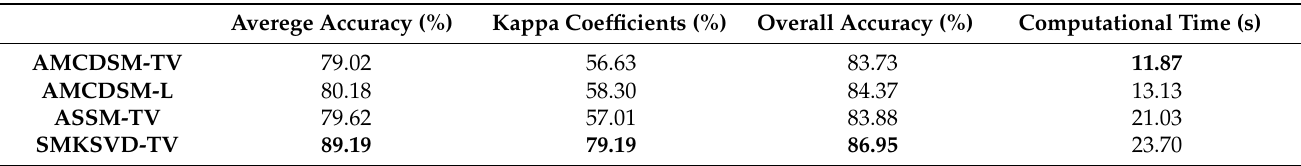
Table 3. Average accuracies, Kappa coefficients, overall accuracies, and computational time of different methods: Jasper ridge